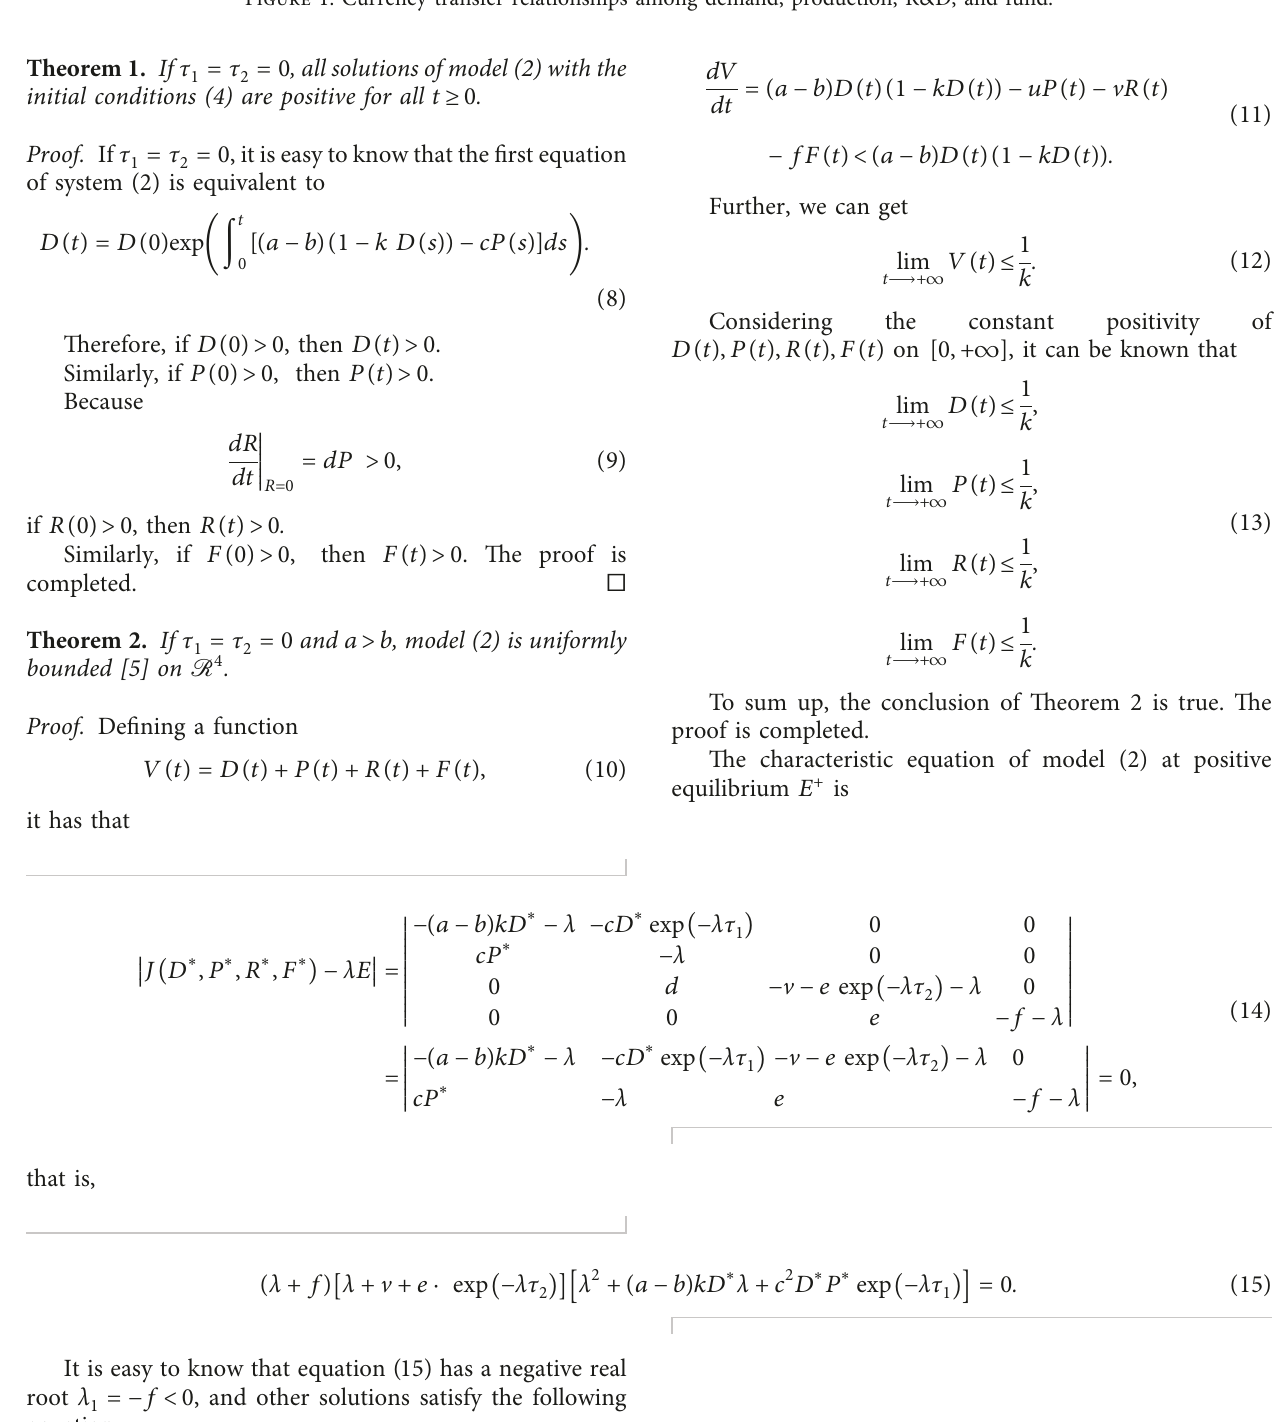
Figure 1: Currency transfer relationships among demand, production, R&D, and